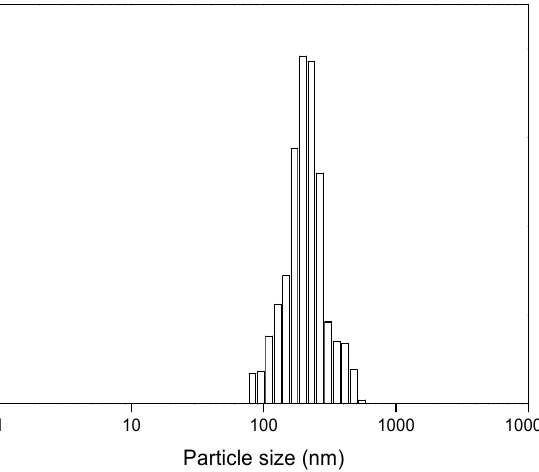
Figure 2. Particle size distribution of the PUA coating.